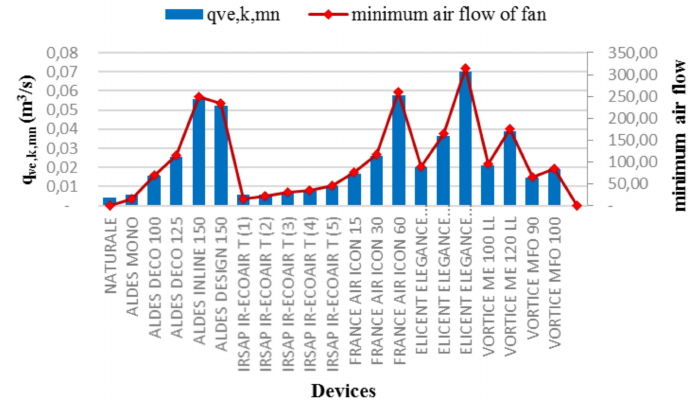
Figure 2. Relationship between q ve,k,mn and minimum air flow of fan. NB: all the figures use dots and commas as per Italian standards.